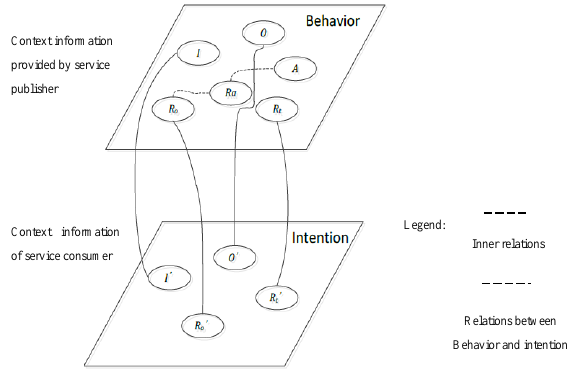
Figure8. Pragmatic web service based on Behavior-Intention model